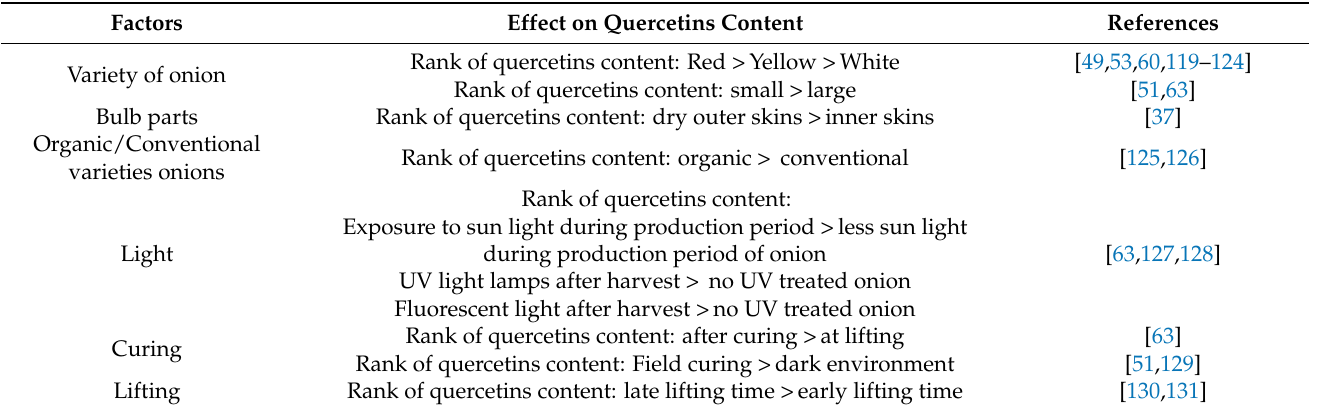
Table 2. Studied factors influencing the content of quercetins during pre-harvest in onions. Factors Effect on Quercetins Content Variety of